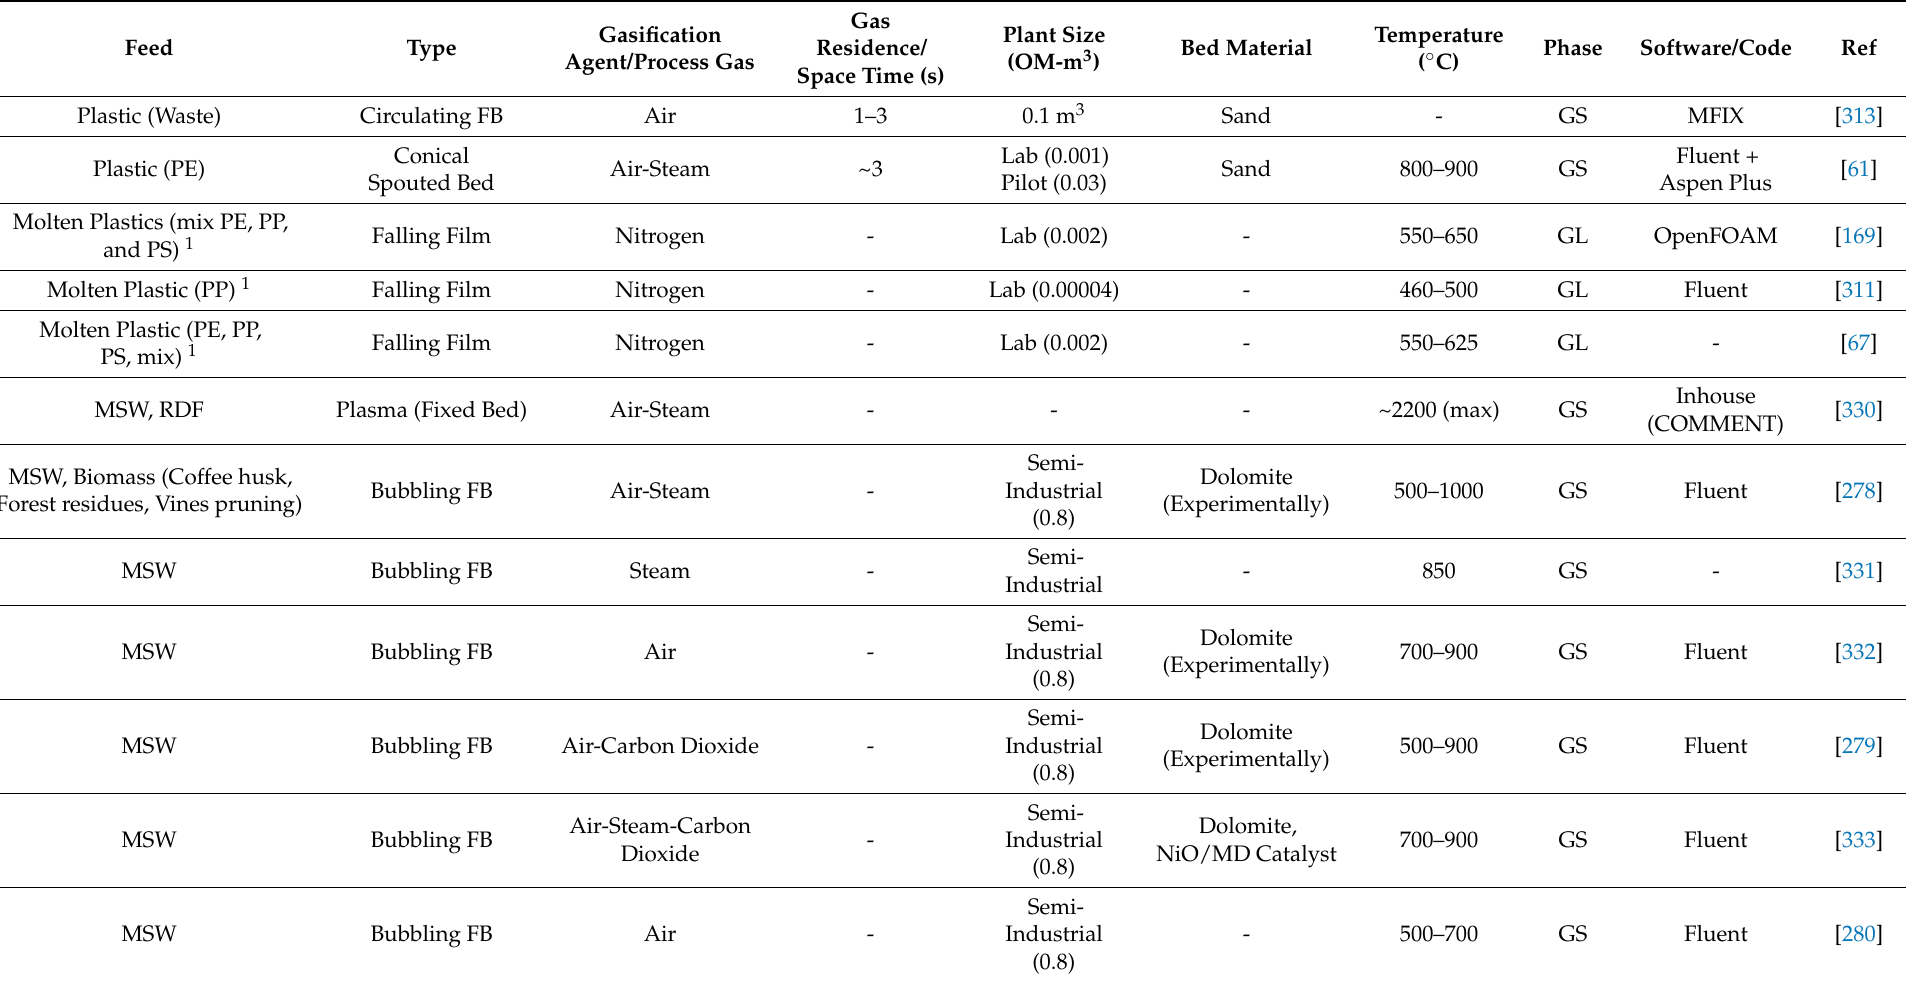
Table 6. Overview of Eulerian-Eulerian simulation studies for different feedstocks and reactor designs that can be used as a guide in the PWG